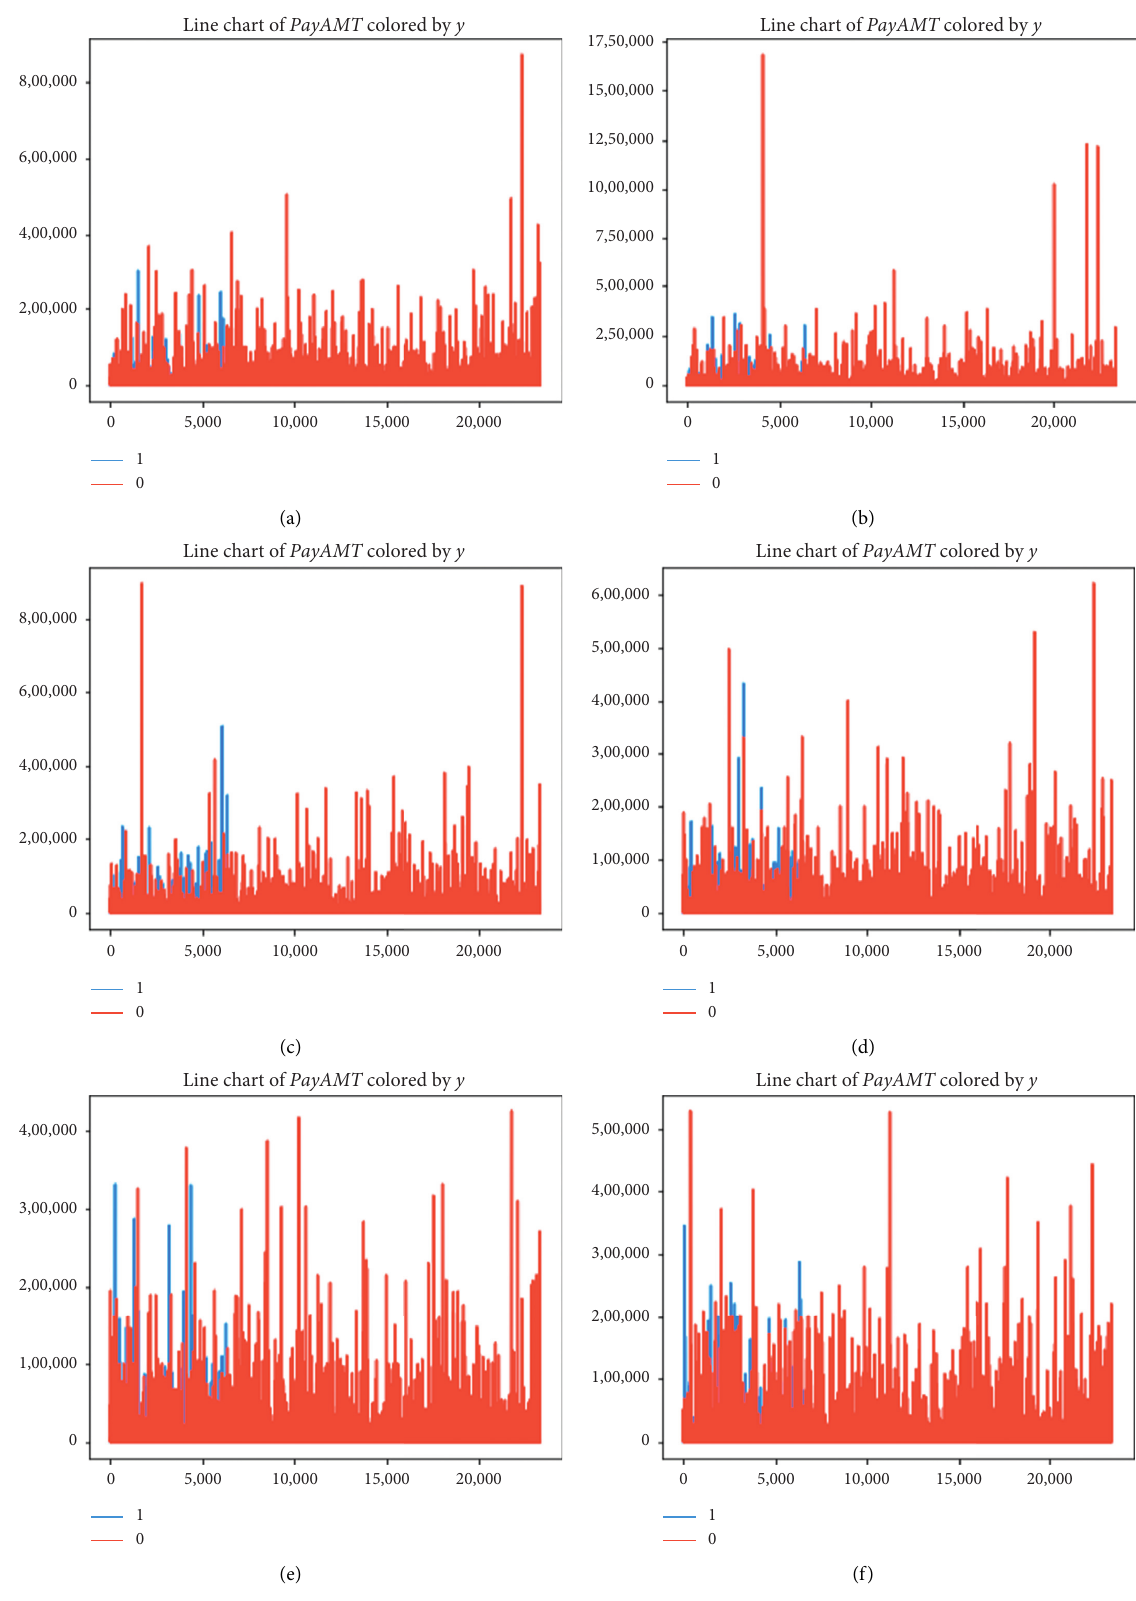
Figure 9: Line chart of payment. (a) Amount of previous payment in September. (b) Amount of previous payment in August. (c) Amount of previous payment in July. (d) Amount of previous payment in June. (e) Amount of previous payment in May. (f) Amount of previous payment in